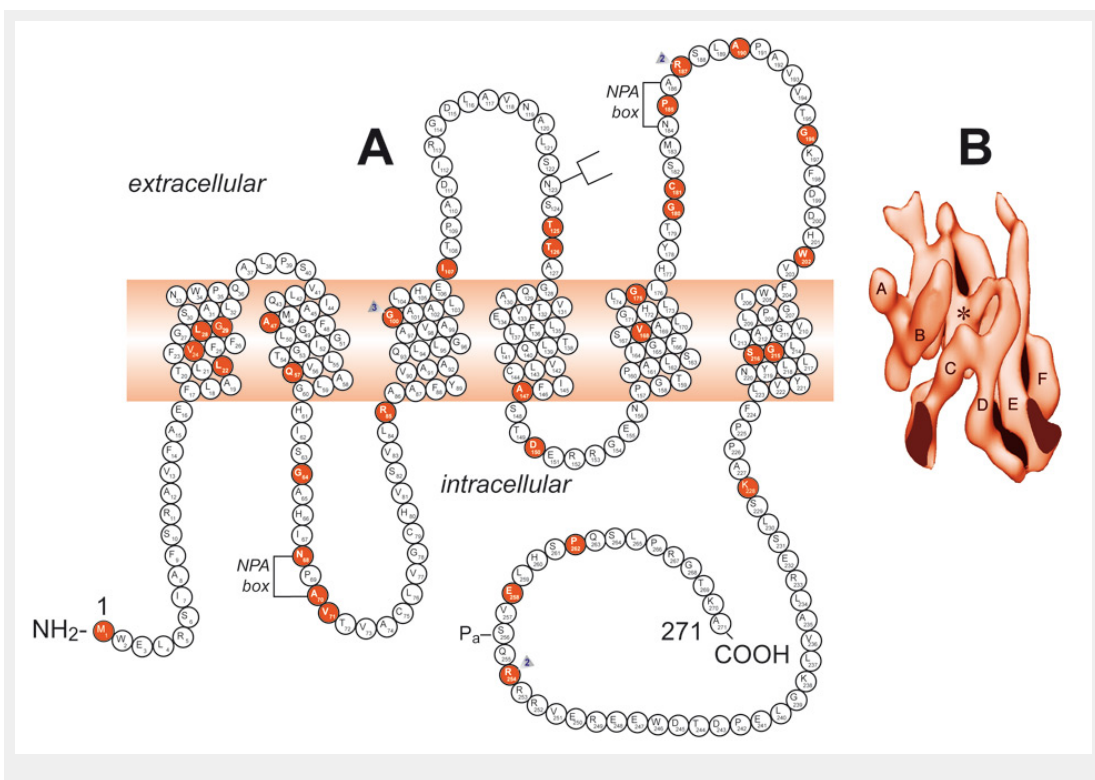
Figure 6 A Schematic representation of the aquaporin-2 protein and identification of 46 AQP2 mutations. A monomer is represented with six transmembrane helices. The location of the protein kinase A phosphorylation site (Pa) is indicated. The extracellular, transmembrane, and cytoplasmic domains are defined according to Deen et al. [82] Solid symbols indicate the mutations’ location. B A surface-shaded representation of the six-helix barrel of the AQP1 protein viewed parallel to the bilayer. (From: Bonnardeaux A, Bichet DG. Inherited disorders of the renal tubule. In: Brenner BM (ed). The Kidney. 8th ed. New York: Harcourt Health Sciences; 2008. p. 1382‒1419. © Elsevier, Oxford, UK, with kind